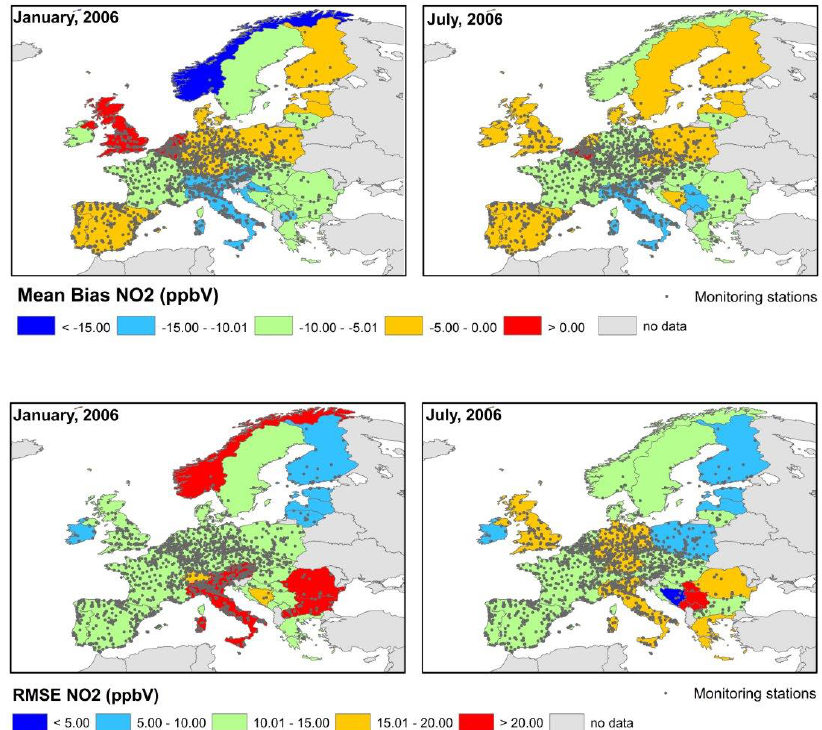
Fig. 5. Mean Bias and RMSE for hourly average NO 2 mixing ratios for the European countries (dots show the distribution of NO 2 monitoring